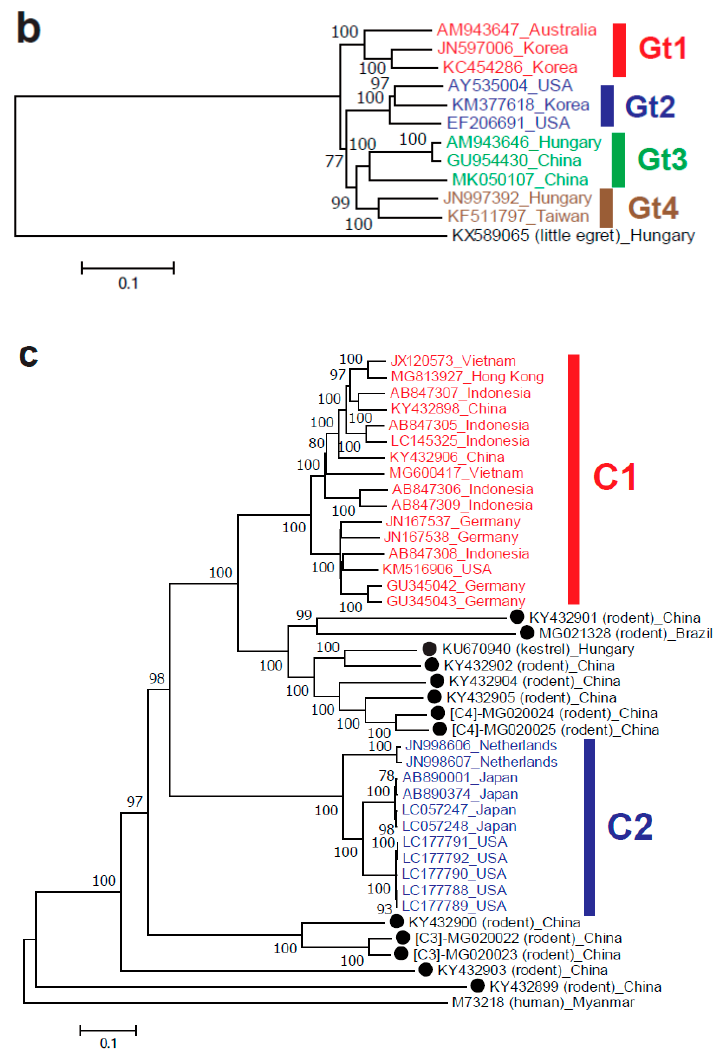
Figure 2. Phylogenetic trees for member of the Orthohepevirus genus. Maximum-likelihood trees were created using MEGA 7 [24] based on entire genomic sequences from members of the Orthohepevirus A species ( a ), Orthohepevirus B species ( b ) and Orthohepevirus C species ( c ). Each reference sequence is shown with genotype / subtype (if available) followed by accession number and the country where it was isolated. ( a ) Subtypes 3l a , 3l b , 3k c and 1g d have been proposed by Wang et al. [68], De Sabato et al. [69], Miura et al. [67] and Nishizawa et al. [65], respectively, and those provisionally proposed by HEVNet (https://www.rivm.nl/en/hevnet) are indicated in brackets. ( b ) Provisional genotypes 1–4 for avian HEV strains are abbreviated as Gt1, Gt2, Gt3 and Gt4, respectively. ( c ) Genotypes C3 and C4 proposed by Wang et al. [78] are indicated in brackets. Reference HEV sequences from moose (KF951328) ( a ), little egret (KX589065) ( b ) and human (HEV-1) (M73218) ( c ) were used as an outgroup. Unassigned HEV strains are highlighted with closed circles. The bootstrap values (>70%) for the nodes are indicated as percentage data obtained from 1000 resampling analyses. The scale bar indicates the number of nucleotide substitutions per site.